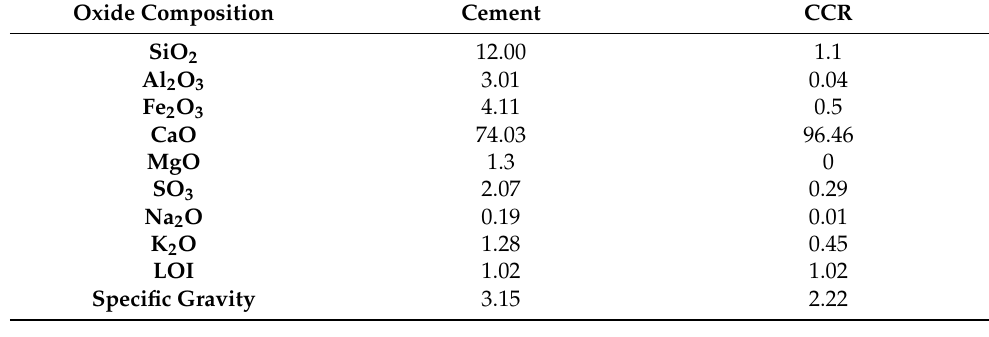
Table 1. Properties of binder materials.